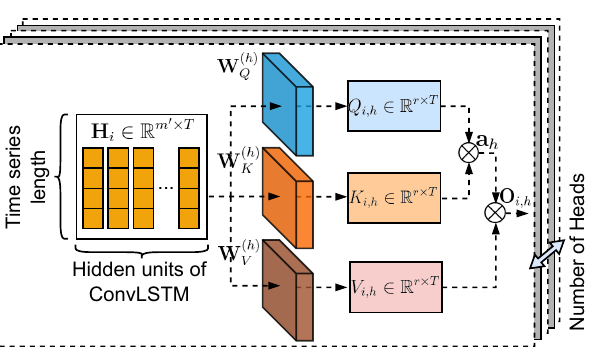
Figure 3. The framework of the multi-head attention model for traffic flow